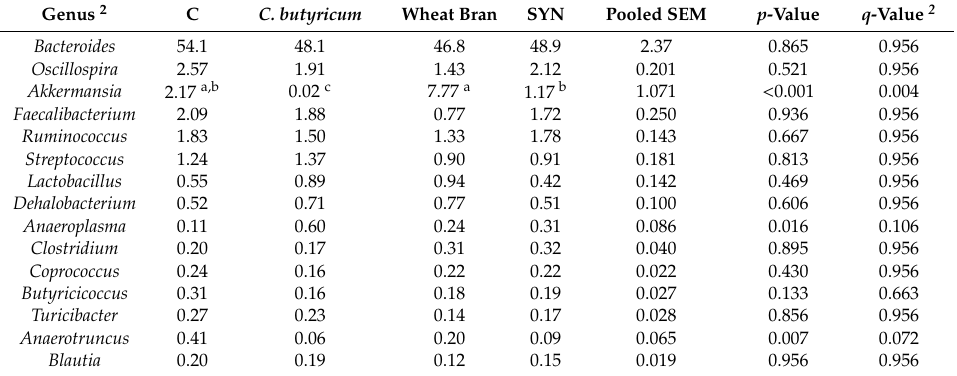
Table 6. Relative abundances (%) of bacterial genera ( > 0.1%) in the cecal contents of broiler chickens (at day 37 of life) 1